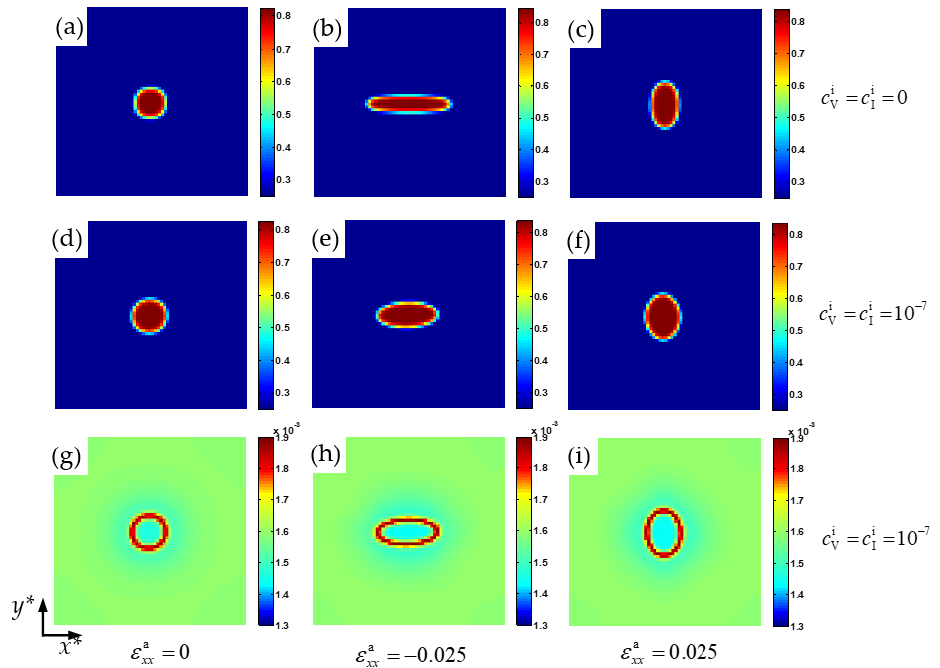
Figure 1. Morphology of the Cr- enriched α′ nanophase ( a – f ) and vacancy ( g – i ) at 750 K for t* = 50. = c i = 0, ( d – i ) c i = c i = 1 × 10 − 7 . ( a , d , g ) ε a ( a – c ) c i V I V I ( a – c ) 025.0 a = . xx